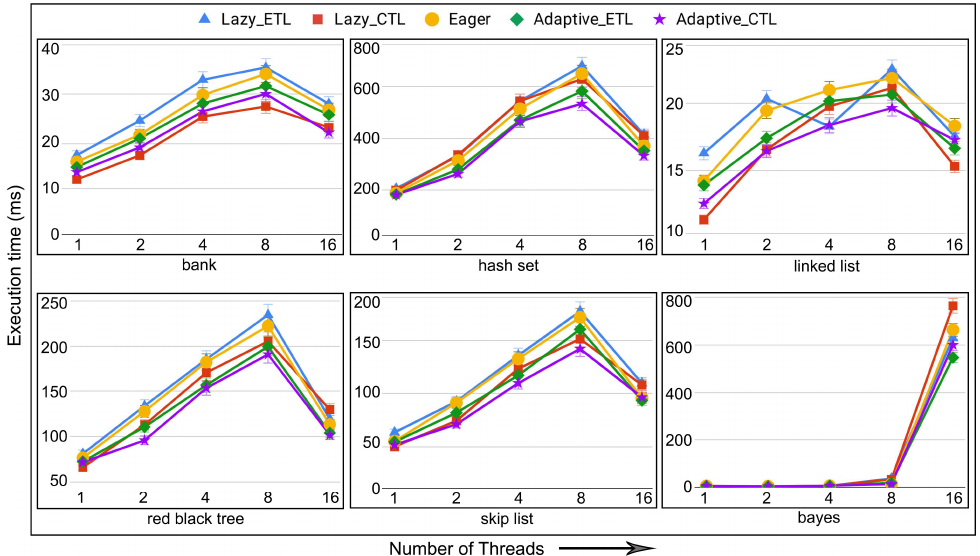
Figure 16. Execution time in micro-benchmarks and bayes from STAMP executing in persistent